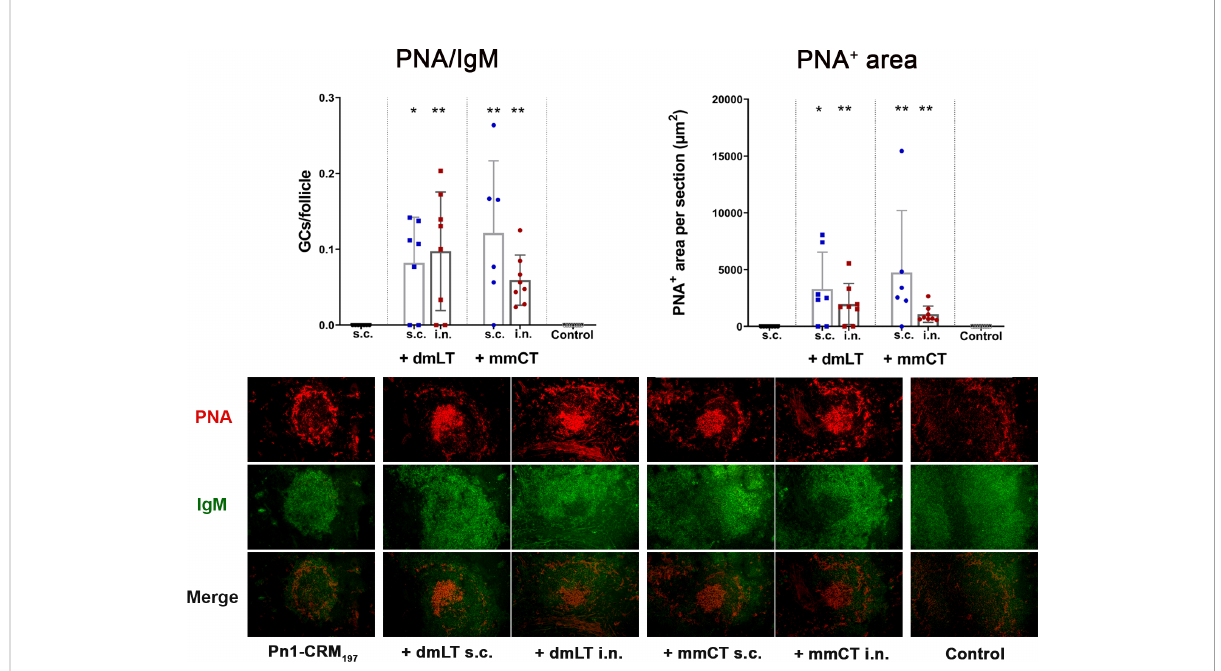
FIGURE 4 The adjuvants dmLT and mmCT enhance germinal center induction irrespective of the immunization route. Spleen sections were stained with anti-IgM and PNA 2 weeks after s.c. or i.n. immunization of neonatal mice with Pn1-CRM 197 with/without 5 m g of dmLT or mmCT. PNA/IgM ratio represents activated GCs in relation to total number of follicles and PNA + area represents total area of positive PNA staining per section. Results are expressed as mean ± SD in 6 – 8 mice per group and statistical difference was calculated using Mann – Whitney U-test where adjuvant groups were compared to vaccine only group and immunization routes were compared between the adjuvanted groups. *p < 0.05, **p < 0.01.